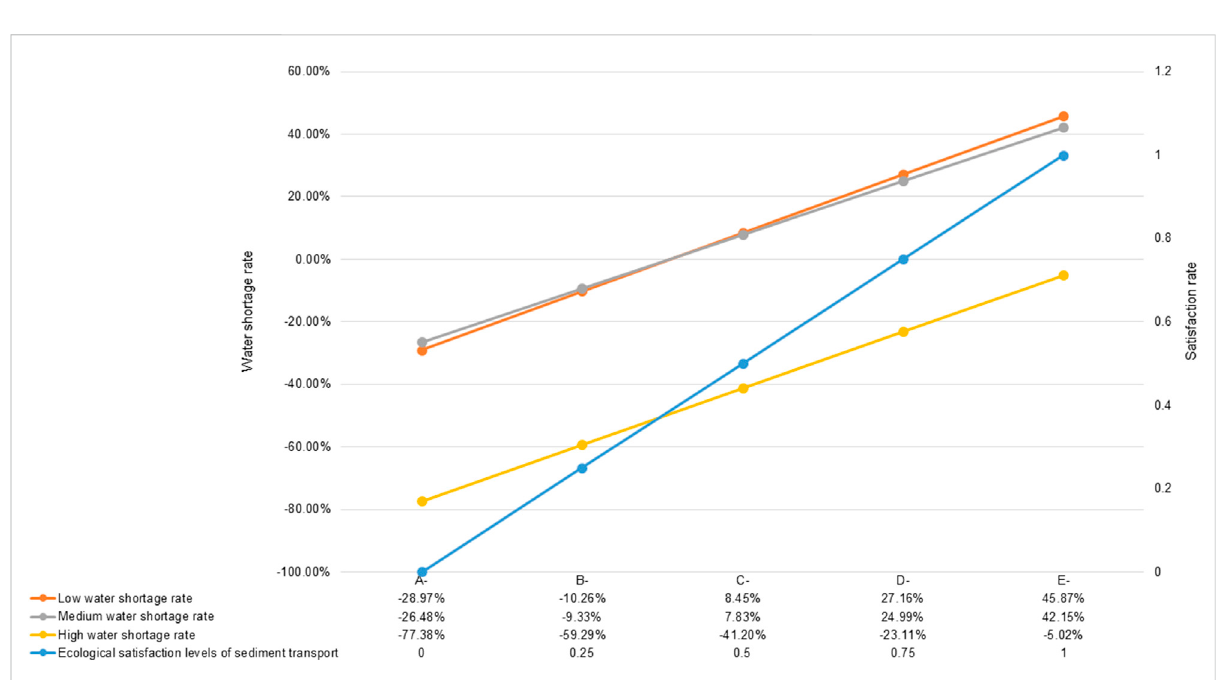
FIGURE 3 Changes in satisfaction and water shortage rate under different scenarios (2025)